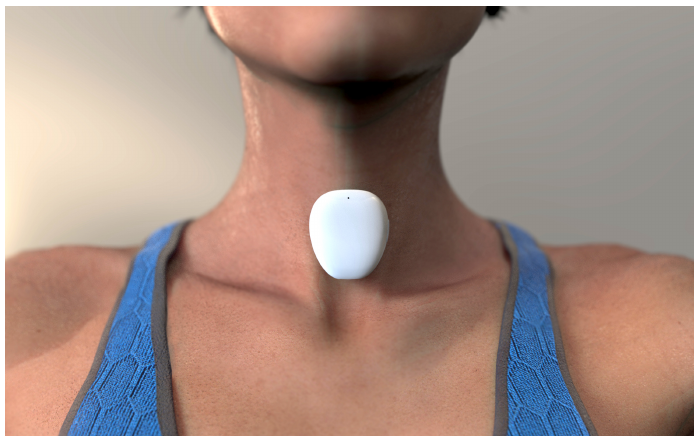
Figure 1. The placement of the Clebre audio and motion